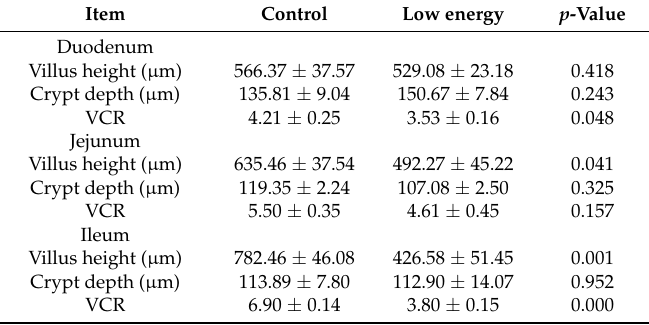
Table 5. Effect of different energy level during gestation on intestinal morphology in newborn pigs.